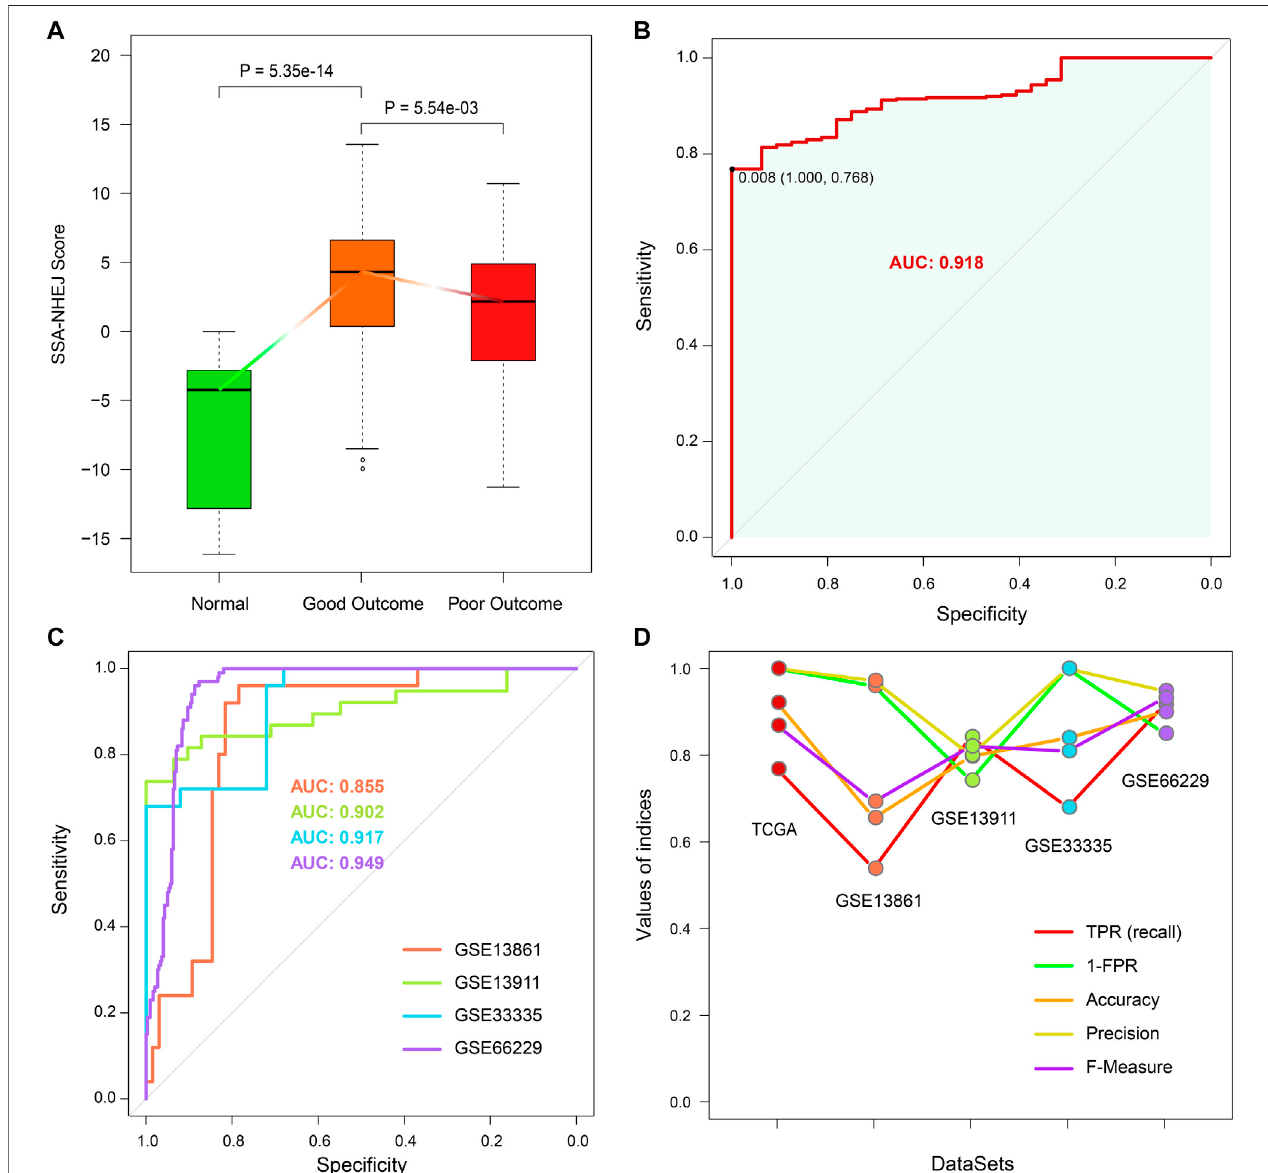
FIGURE 8 | Constructing Cancer-Normal model and predicting the status of samples. (A) SSA-NHEJ score of a normal, good outcome, and poor outcome samples. p values were evaluated by Wilcoxon test. (B) ROCcurveofpredicting TCGA STAD cancer and normal samples. 0.008 isselected tobe the cutoff to predict a sampleasnormalor cancerstatus. (C) ROCcurvesofpredicting sample status infourindependentGEOcohorts.AUC valuesarelisted. (D) Fivemeasuresofpredictive effect for TCGA and four GEO cohorts are listed, including true positive rate, 1 — false-positive rate, accuracy, precision, and F-measure.